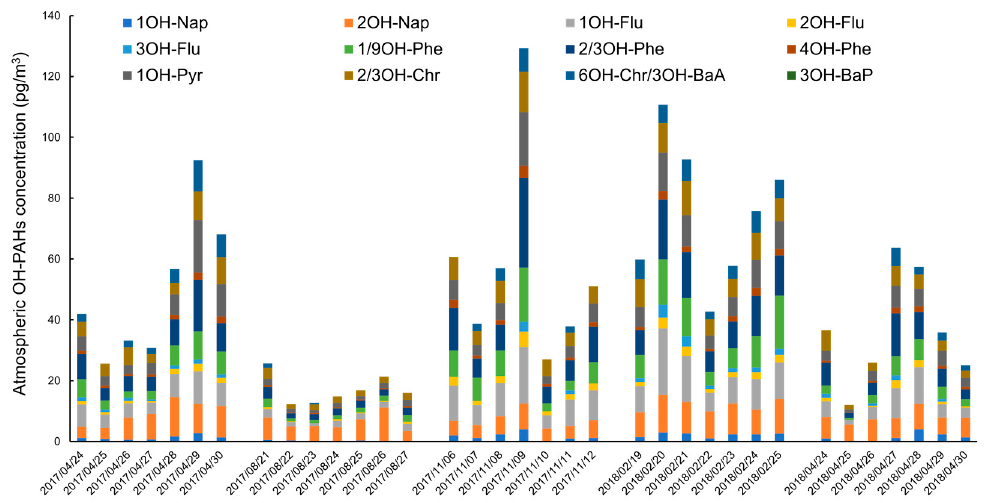
Figure 2. Daily atmospheric concentrations of OH-PAHs in April, August, and November 2017, and February and April 2018 in Kanazawa.